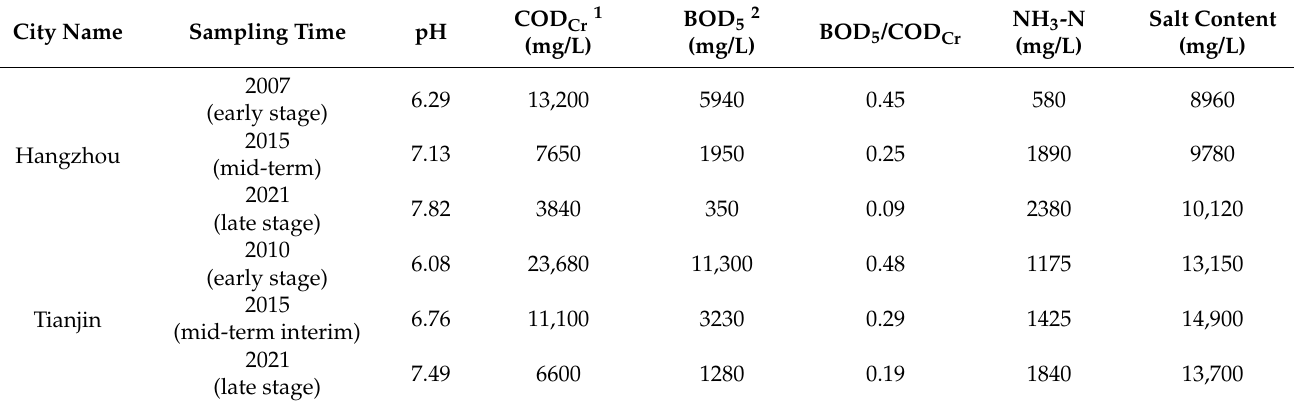
Table 1. Leachate characteristics of the Hangzhou and Tianjin landfills (annual